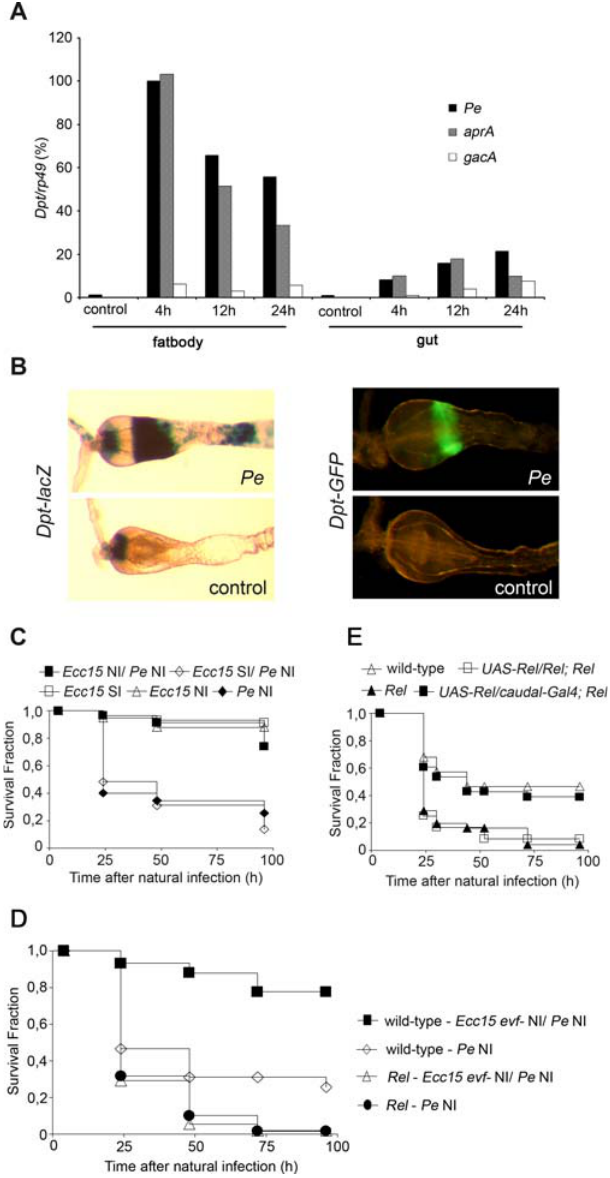
Figure 5. The Local Immune Response Plays a Critical Role against P. entomophila (A) Time course analysis of Diptericin expression measured by RT-qPCR in Drosophila fat body and gut extracted from females following natural infection with wild-type P. entomophila, aprA, and gacA mutants. Infection with wild-type P. entomophila and the aprA mutant induced a rapid and sustained Diptericin expression unlike the gacA mutant. Fat bodies (carcasses) and digestive tracts were dissected from adults collected at different time intervals after oral infection. Diptericin expression was normalized to rp49 mRNA. 100% value corresponds to the level of Dpt mRNA obtained 4 h after infection with wild-type P. entomophila . rp49 : ribosomal protein 49 ; Dpt, Diptericin (B) P. entomophila induces Diptericin expression in the cardia of adult Drosophila . Histochemical staining of b -galactosidase activity shows that Dpt-lacZ is expressed in the anterior midgut at the level of the proventriculus of infected flies carrying the Dpt-lacZ reporter gene (left panel). Similar results were obtained with a Dpt-GFP transgene (right panel) . Adults were collected 24 h after infection. The control pictures display the cardia of uninfected flies. A constitutive expression was observed in the anterior part of the cardia. Dpt, Diptericin . (C) Survival of wild-type flies ( n ¼ 60) to P. entomophila after previous infection with Ecc15 . Flies were first infected with Ecc15 either